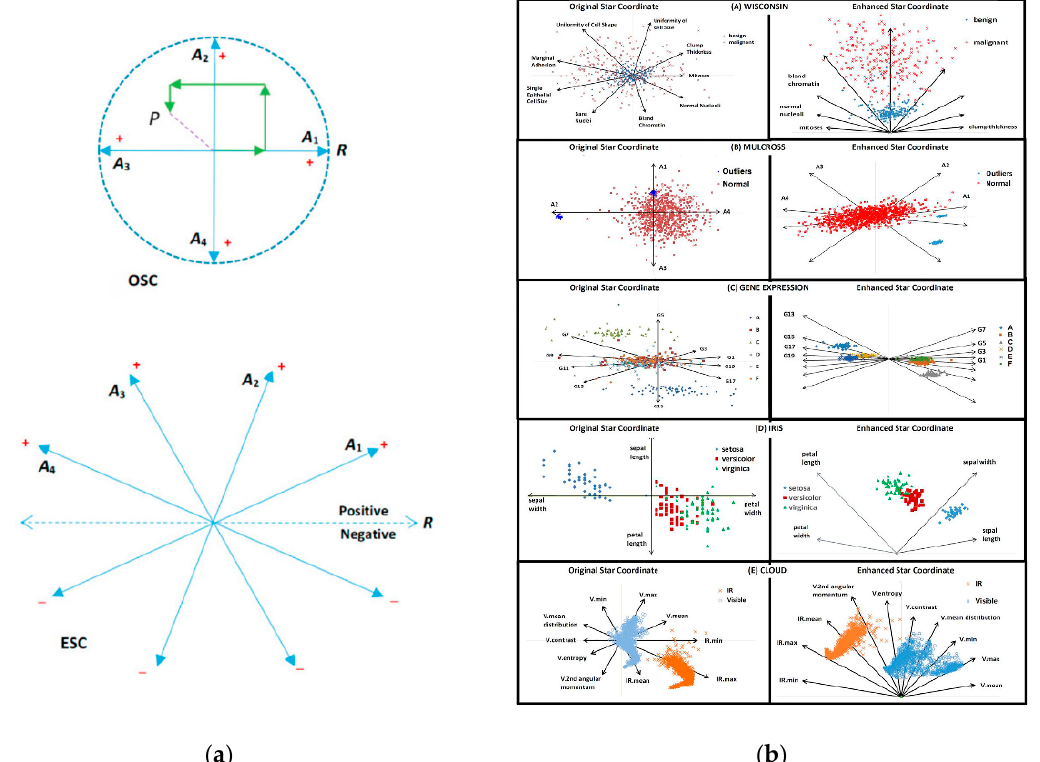
Figure 38. ( a ) Original star coordinate system with a sample of point P (top) and enhanced star coordinate system (bottom) [99]; and ( b ) comparisons of visualization results between original star coordinates and enhanced star coordinates in an example dataset [100].